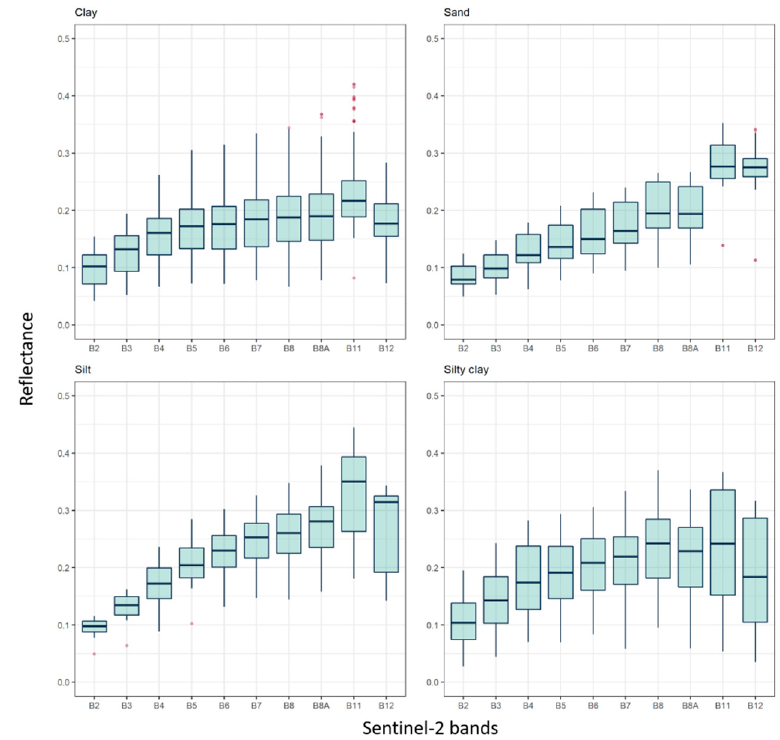
Figure 8. Temporal variability of soil reflectance for randomly selected clay, sand, silt and silty clay example the upper and down boxes indicates the 1st and 3rd quartiles, respectively.